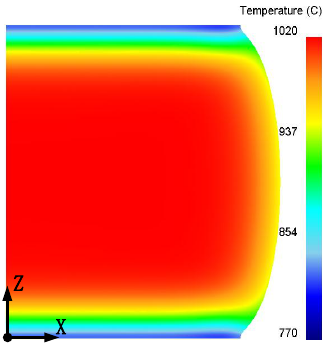
Figure 5. Temperature of the upsetting.